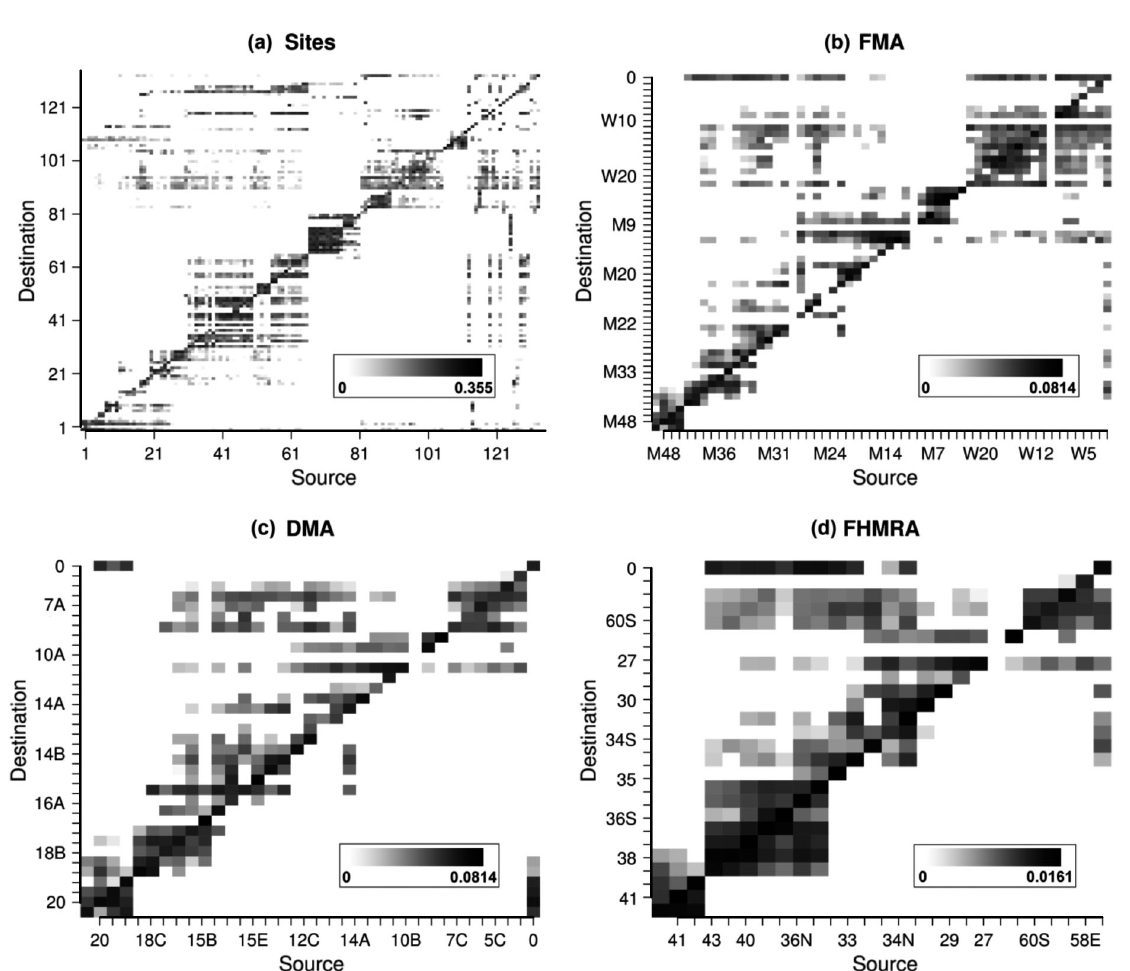
Fig. 4. Mean connectivity between (a) active sites, (b) Farm Management Areas (FMAs), (c) Disease Management Areas (DMAs) and (d) Fish Health Management Reporting Areas (FHMRAs) on the west coast of Scotland (sites/management units arranged south to north). For codes and details on management areas see Tables S1–S3 in the Supplement at www.int- res.com/articles/q008p585_supp.pdf. Connectivity is shaded on a logarithmic scale between 0 and a different upper limit in each panel, indicated in the scale bars